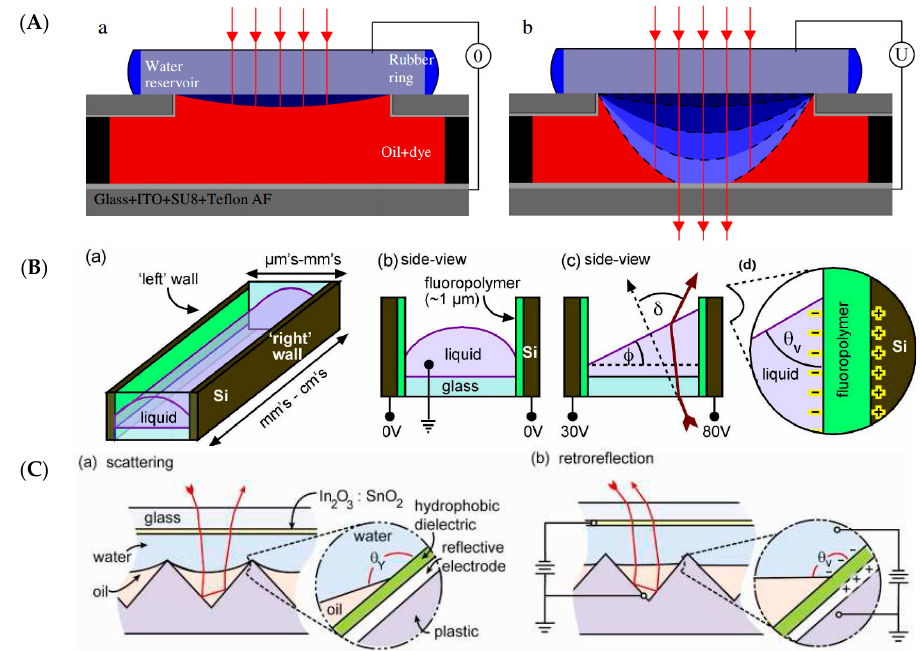
Figure 10. ( A ) ( a ) Incident light beam is absorbed by the “Oil + dye” medium; ( b ) application of voltage “U” exerts electrical Maxwell stress on the water-oil meniscus, enabling the incoming light to pass through the “Oil + dye” medium. With kind permission of the Optical Society of America (OSA). Adapted from Murade, C.U.; Oh, J.M.; van den Ende, D.; Mugele, F. Electrowetting driven optical switch and tunable aperture. Opt. Express 2011 , 19 , 15525–15531. ( B ) Schematic of the electrowetting modulated microprisms. ( a ) Conducting liquid entrapped between the silicon walls coated with fluoropolymer; ( b ) side view of the setup at zero voltage; ( c ) application of voltage, with 30 V (left sidewall) and 80 V (right sidewall), entrapped conducing liquid electrowets the sidewalls, thus forming a triangular prism; ( d ) inset of the contact line at the edge. With kind permission of the Optical Society of America (OSA). Adapted from Smith, N.R.; Abeysinghe, D.C.; Haus, J.W.; Heikenfeld, J. Agile wide-angle beam steering with electrowetting microprisms. Opt. Express 2006 , 14 , 6557–6563. ( C ) Schematic of the retroreflector. ( a ) Concave interface is formed between the low index water and high index oil at zero voltage, exhibiting scattering or semi-diffused reflection. Inset depicting the contact angle θ Y between water, oil, and hydrophobic dielectric deposited on reflective electrode. ( b ) Transition from concave to flat interface at 19 V showing retroreflection. With kind permission of the Optical Society of America (OSA). Adapted from Kilaru, M.K.; Yang, J.; Heikenfeld,